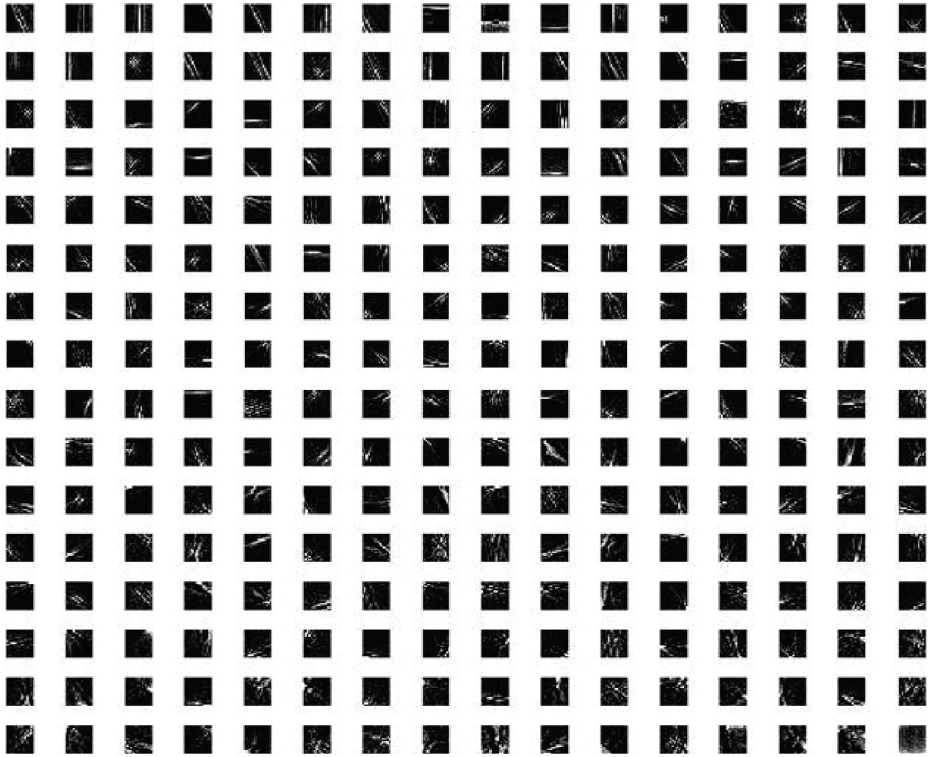
Figure 12: Obtained ICA flters (256) using the image patches of the summer-fall dataset.